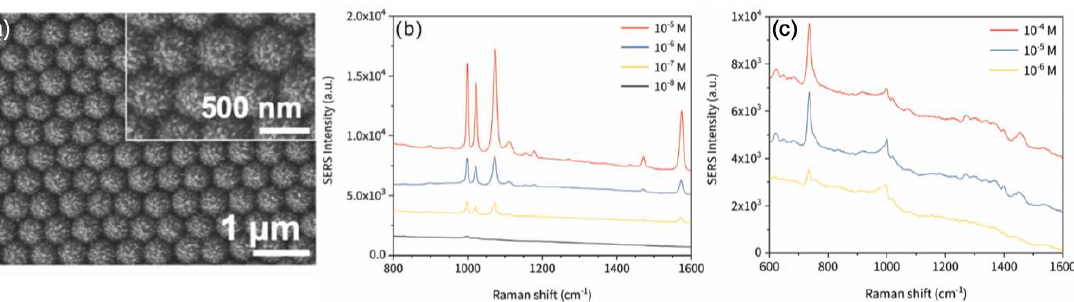
Figure 6. ( a ) SEM picture of Au/ZnO nano-urchins. SERS spectra of thiophenol ( b ) and adenine ( c ) molecules recorded on Au/ZnO nano-urchins for several concentrations of the studied molecules. All the figures are reproduced from [95] with permission from the Royal Society of